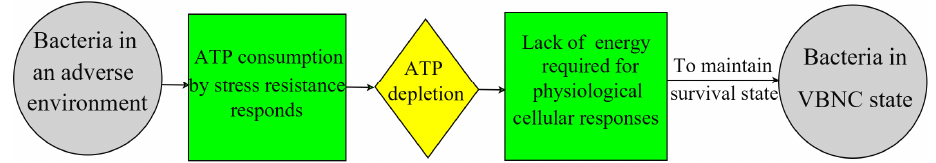
Figure 5. Schematic diagram of ATP regulation theory.